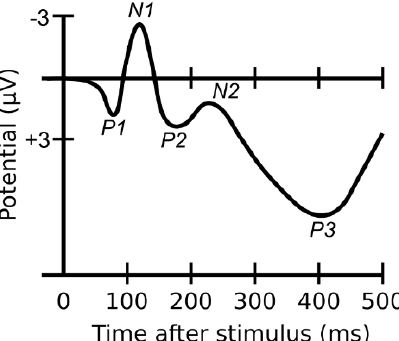
Figure 1. A typical ERP elicited by a visual stimulation.